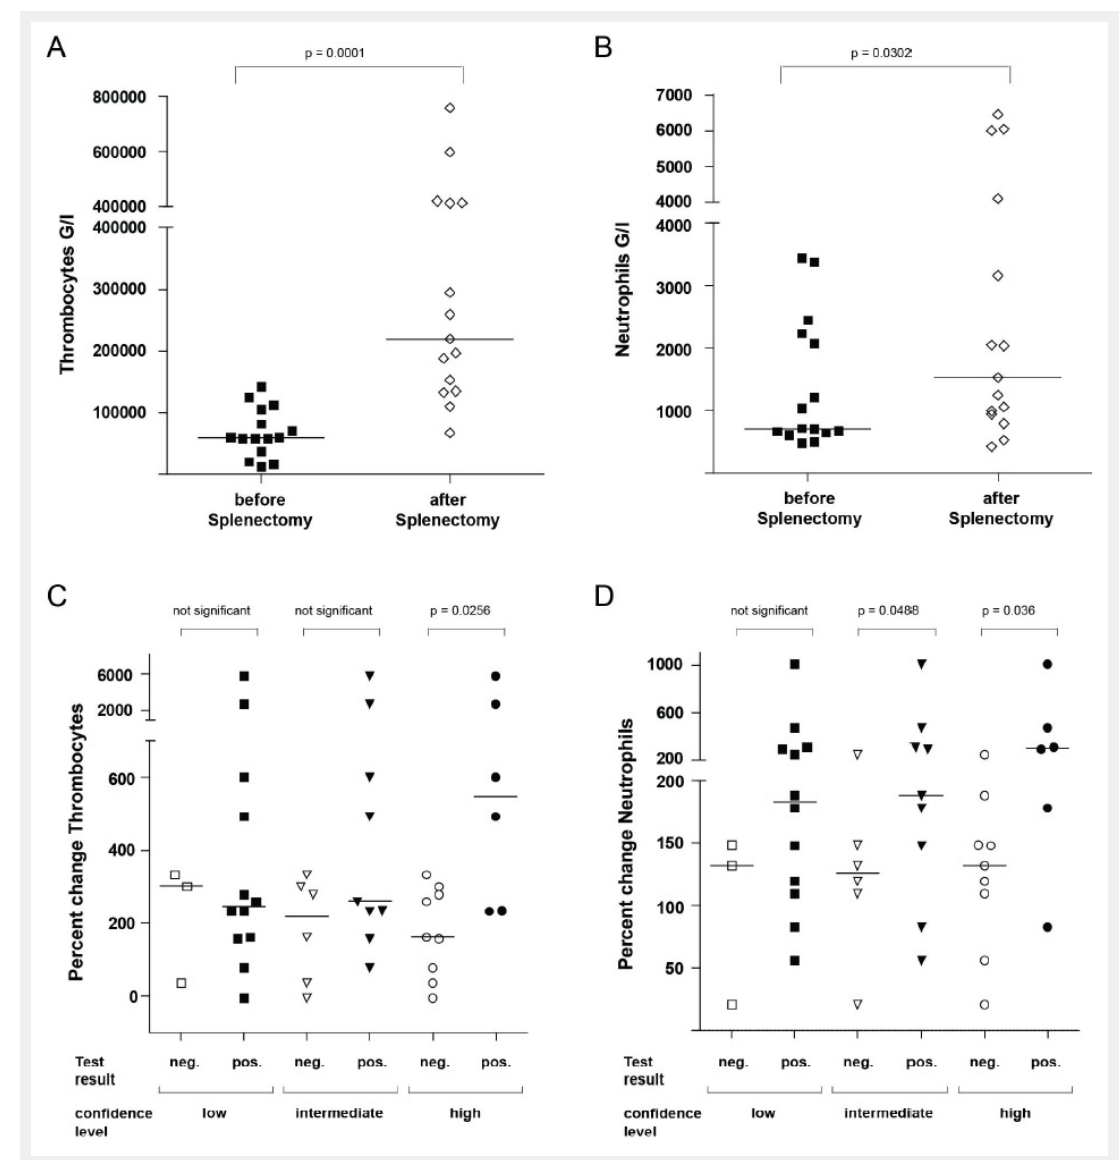
Figure 3 Platelet and neutrophil counts before and after splenectomy according to results of EST. A, B: Thrombocyte and neutrophil counts before and after splenectomy. C, D: Percent change in thrombocyte and neutrophil counts after splenectomy according to the result of EST at different confidence levels. The horizontal lines in the graphs indicate the median of the respective data shown. Significance was calculated using the Wilcoxon signed rank test (A, B) or Mann Whitney U test (C, D)